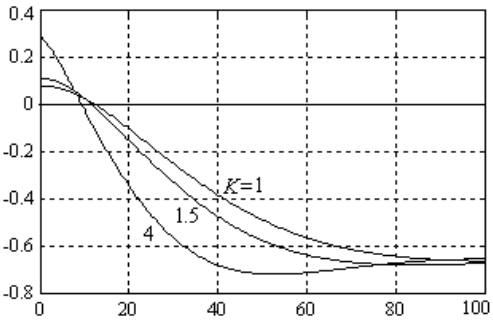
Figure 35. Control responses u ( t ) to a unit step setpoint for K = 1; 1.5;